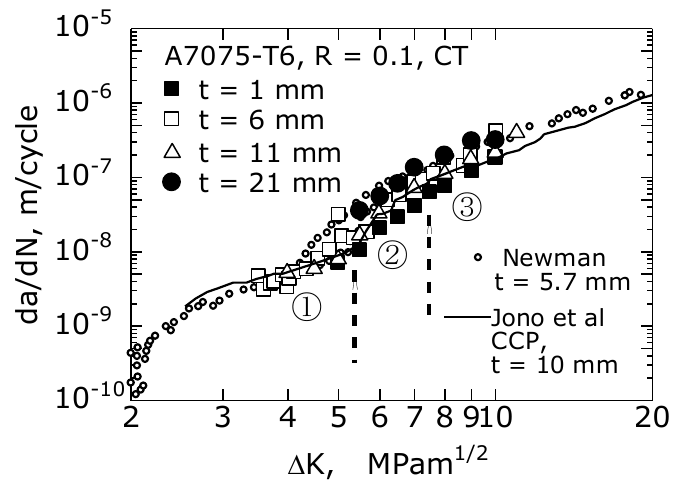
Figure 4. Fatigue crack growth – stress intensity factor range (da/dN –ΔK ) relationship of A7075-T6 and the effect of t on the relationship, ① a low-rate region; ② a medium-rate region; ③ a high-rate region.